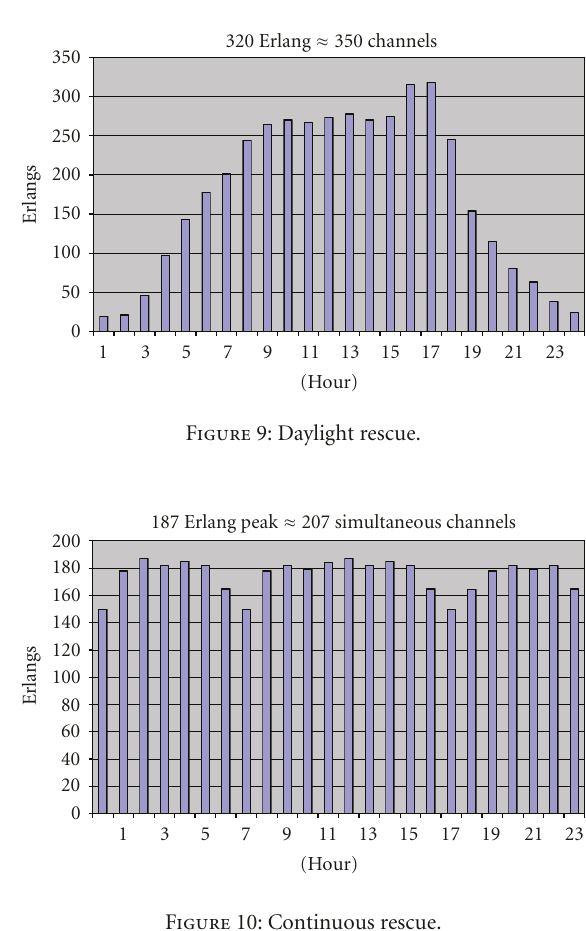
Figure 10: Continuous